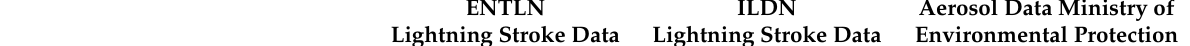
Aerosol Data Ministry